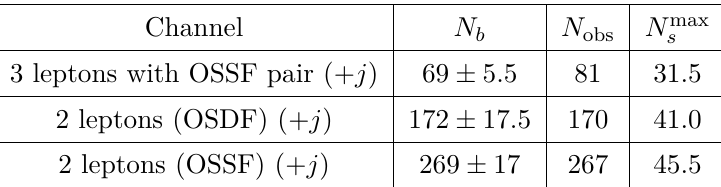
, from the missing energy s